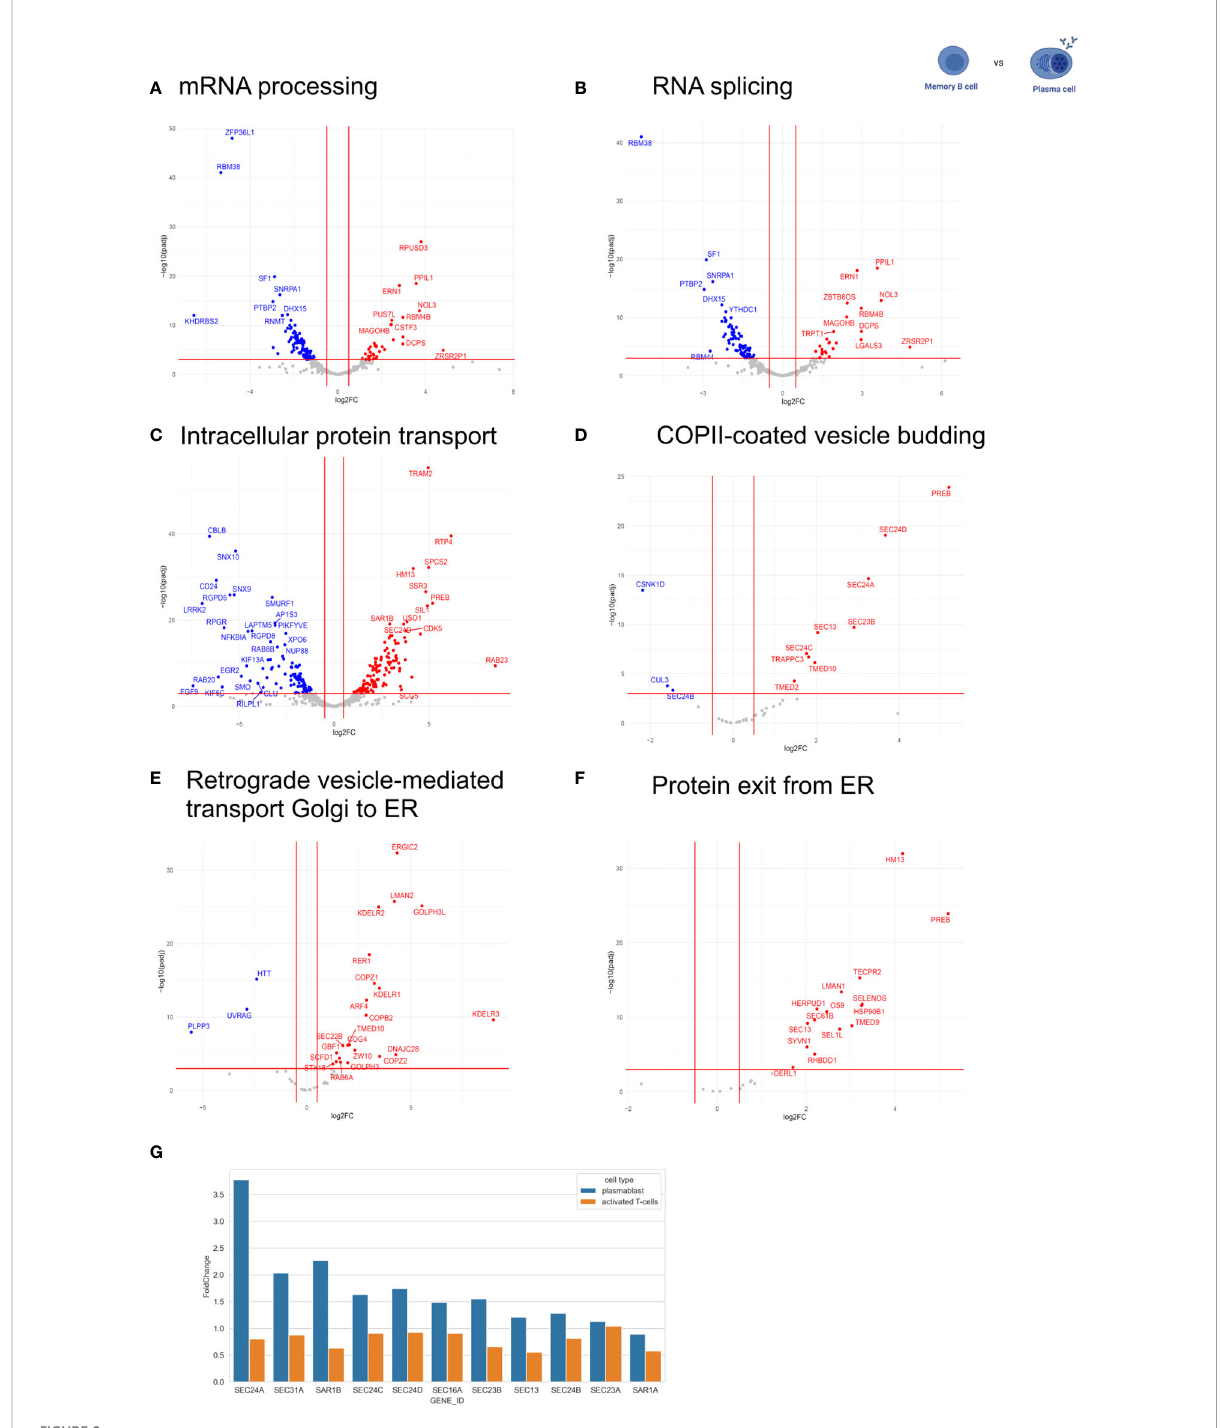
FIGURE 2 Expression of RNA processing-related and intracellular traf fi cking-related genes. The expression of RNA processing-related and intracellular traf fi cking related-genes was compared between MBC and PC. The following GO terms were analyzed: (A) mRNA processing. (B) RNA splicing. (C) intracellular protein transport. (D) COPII-coated vesicle budding. (E) retrograde vesicle-mediated transport Golgi to ER. (F) protein exit from ER. In the volcano plots, log2 fold change (log2FC) was plotted against P ajd < 0.001, fold changes were considered signi fi cant if log2FC > 0.5 (or < -0.5). Genes up-regulated in plasma cells are shown in red (down-regulated in memory). Genes down-regulated in plasma cells are shown in blue (up-regulated in memory). (G) Comparison of gene expression levels of COPII-components in PC compared to prePB and T-cell activation [T-cell data was taken